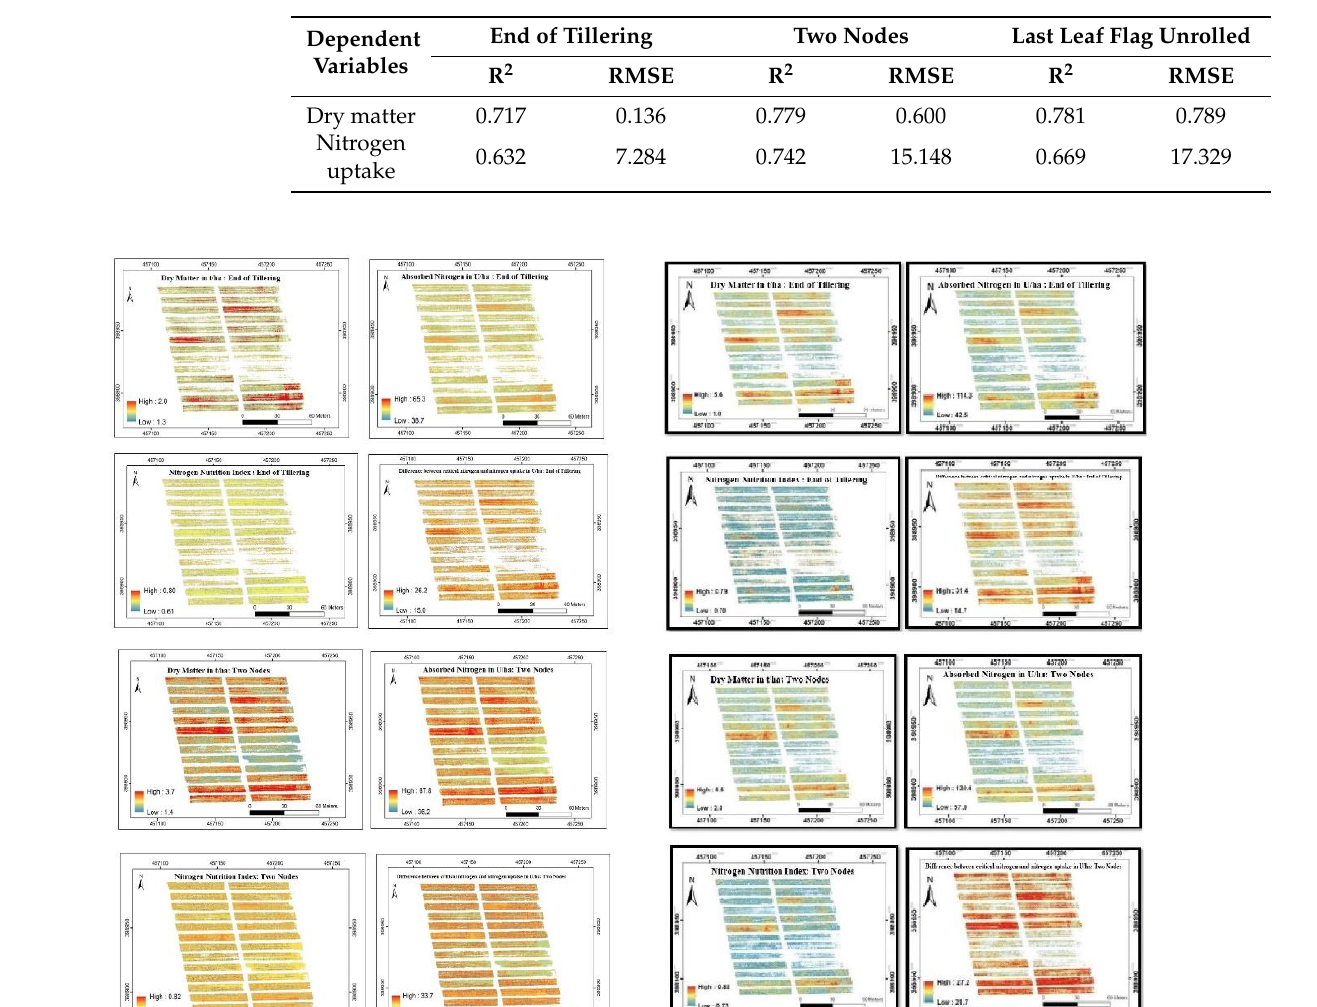
Table 7. Values of R 2 and RMSE by general approach using Random Forest.